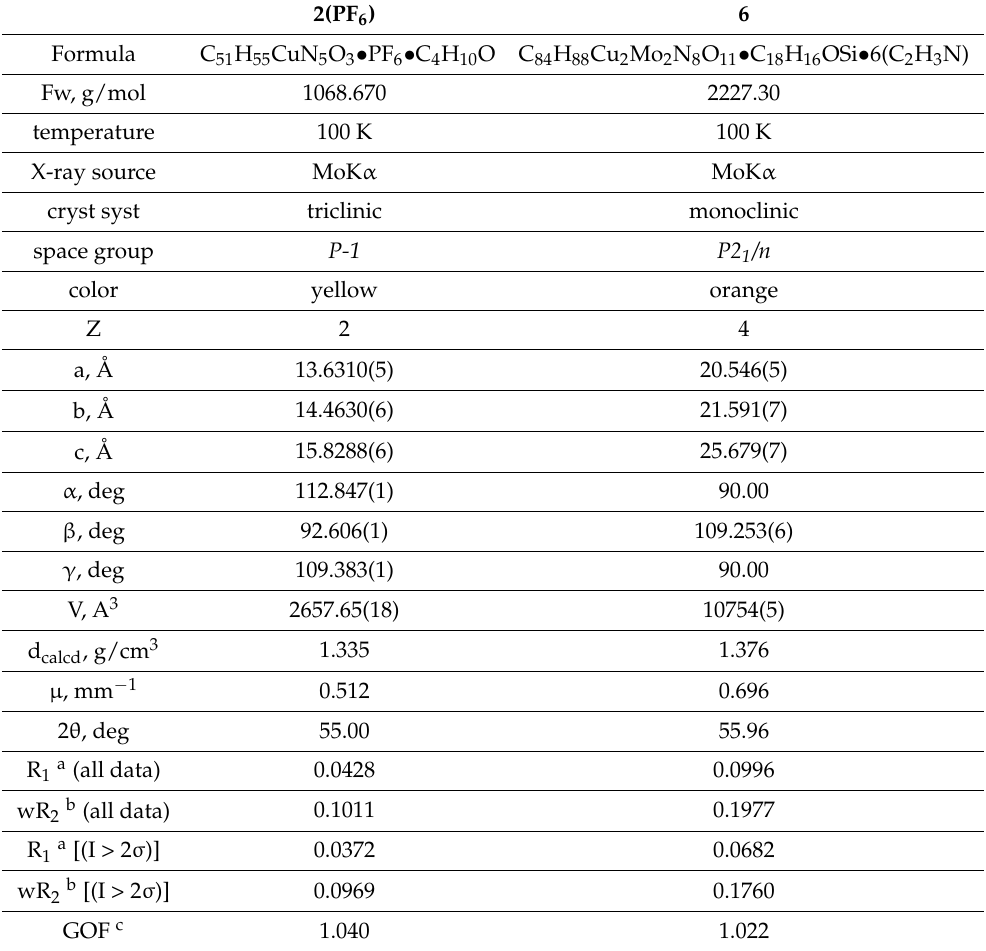
Table 1. Crystal and structure refinement